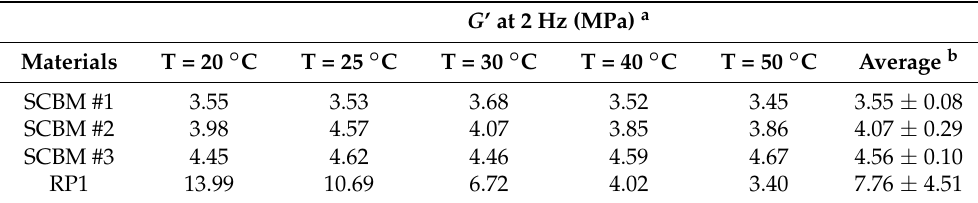
Table 1. The shear storage modulus ( G ’) at 2 Hz for the silicone composite backing materials (SCBMs) and Roma Plastilina No. 1 (RP1) from frequency sweep experiments at different